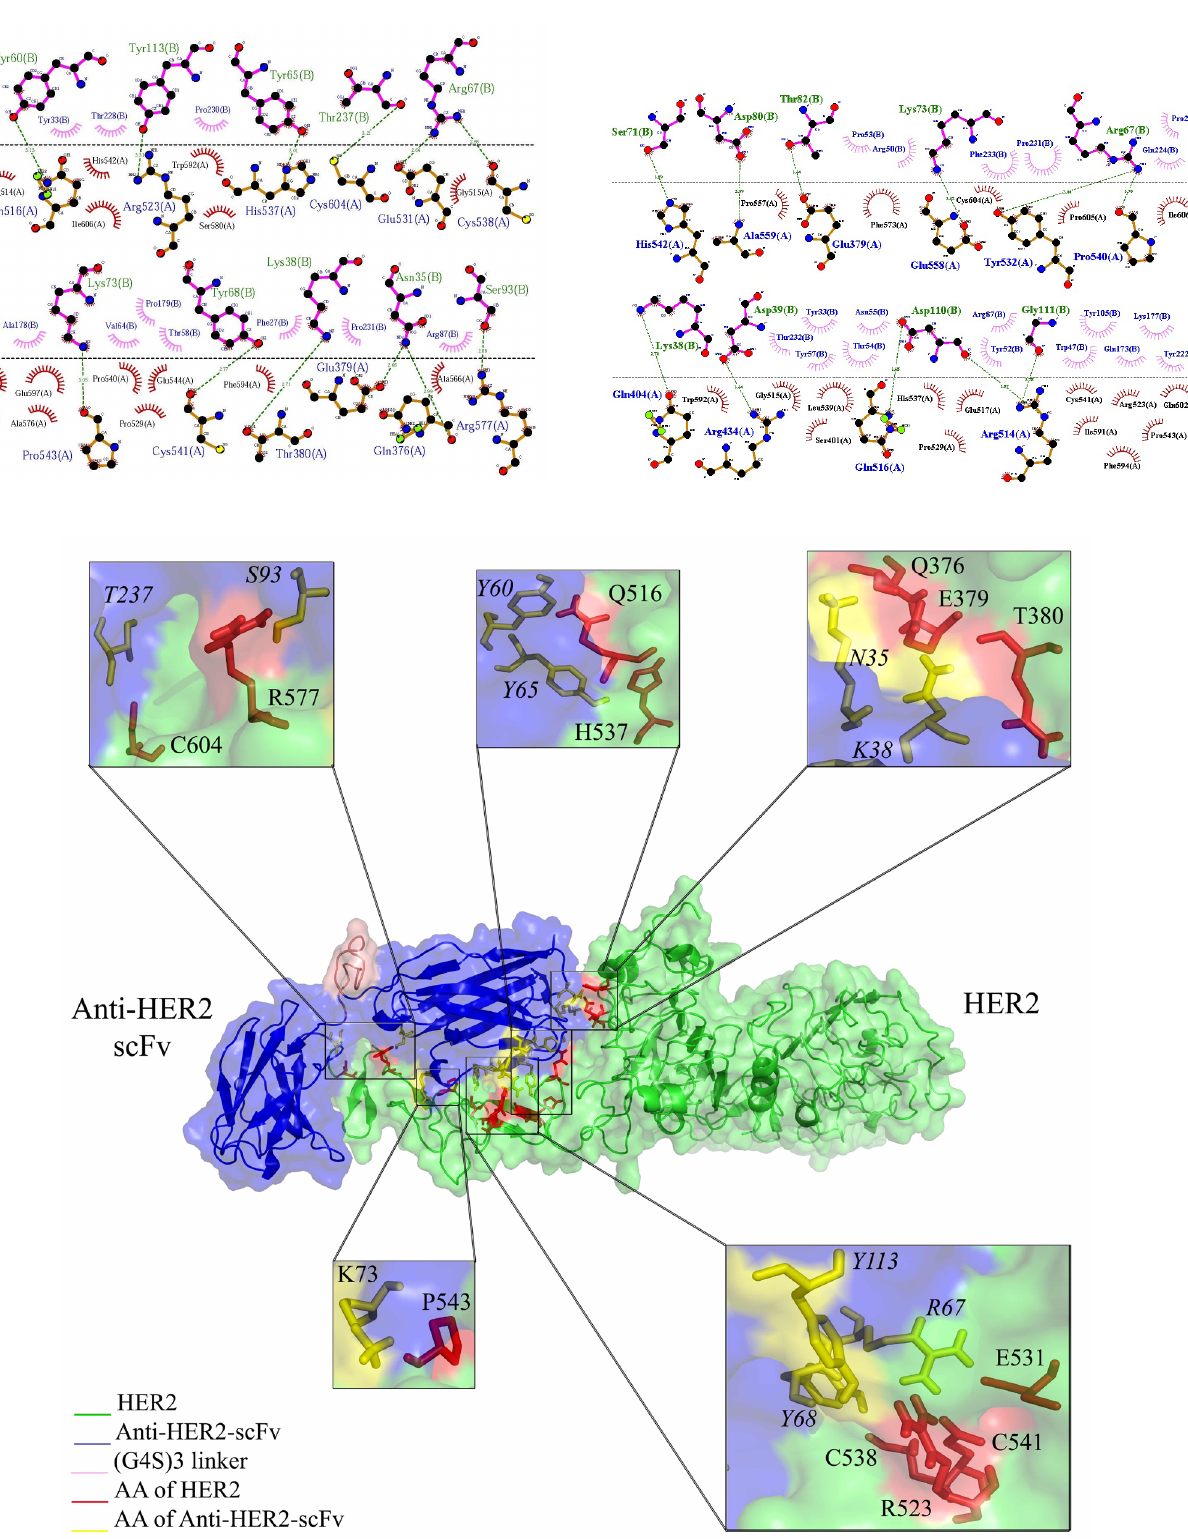
FIGURE 4 - Interaction mode of scFv molecule with the extracellular domain of HER2 protein. Surface-cartoon representation of complex resulted from molecular docking by HADDOCK. Light and heavy chains of scFv, (G in blue, pink and green, respectively. Close-up view of the stick representation of amino acids involved in the interaction of proteins has been colored in yellow and red for scFv and HER2,